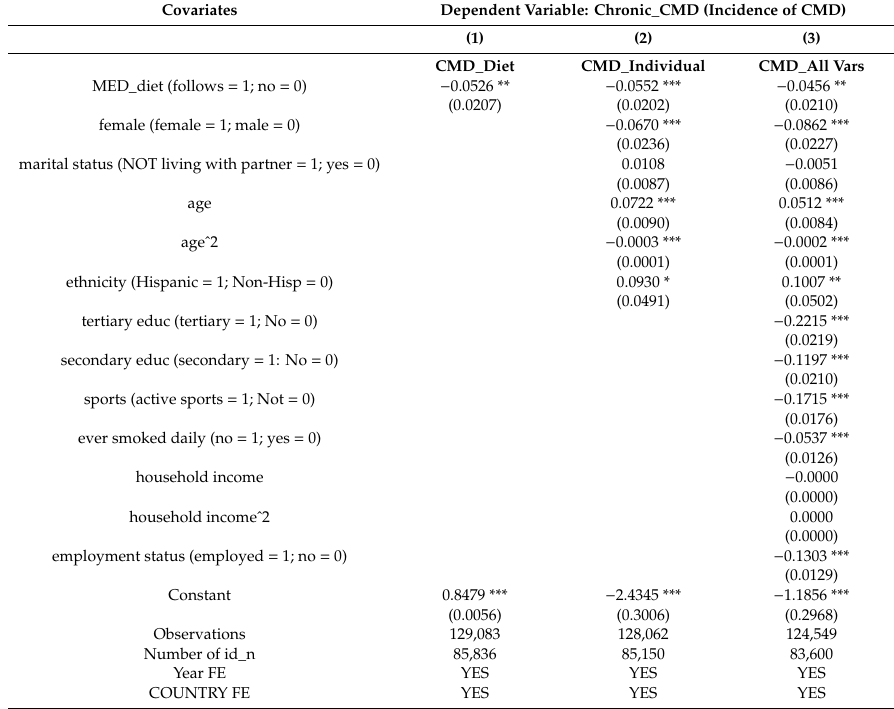
Table 2. Regression analysis relating CMDs with the Mediterranean diet, individual and socio-demographic characteristics and lifestyle behaviors.